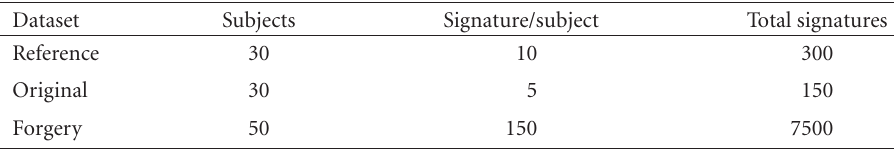
Table 2 . 2 . Signature database organization for